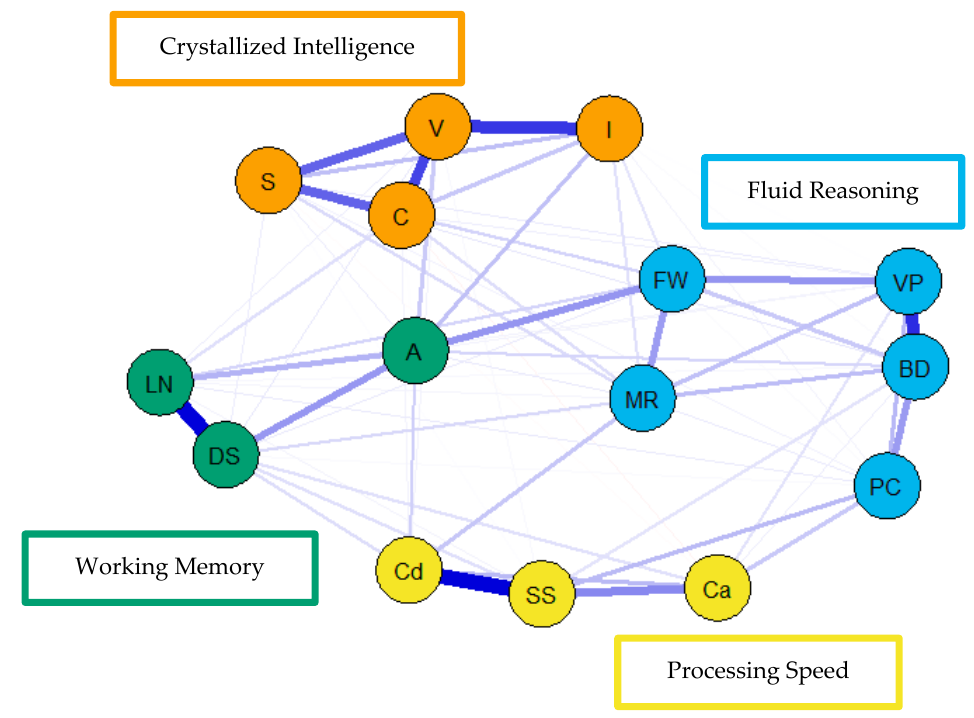
Figure 5. Weighted, undirected psychometric network model of the middle group WAIS-IV correlation matrix. BD = block design; S = similarities; DS = digit span; MR = matrix reasoning; V = vocabulary; A = arithmetic; SS = symbol search; VP = visual puzzles; I = information; Cd = coding; LN = letter–number sequencing; FW = figure weights; C = comparisons; Ca = cancellation; PC = picture